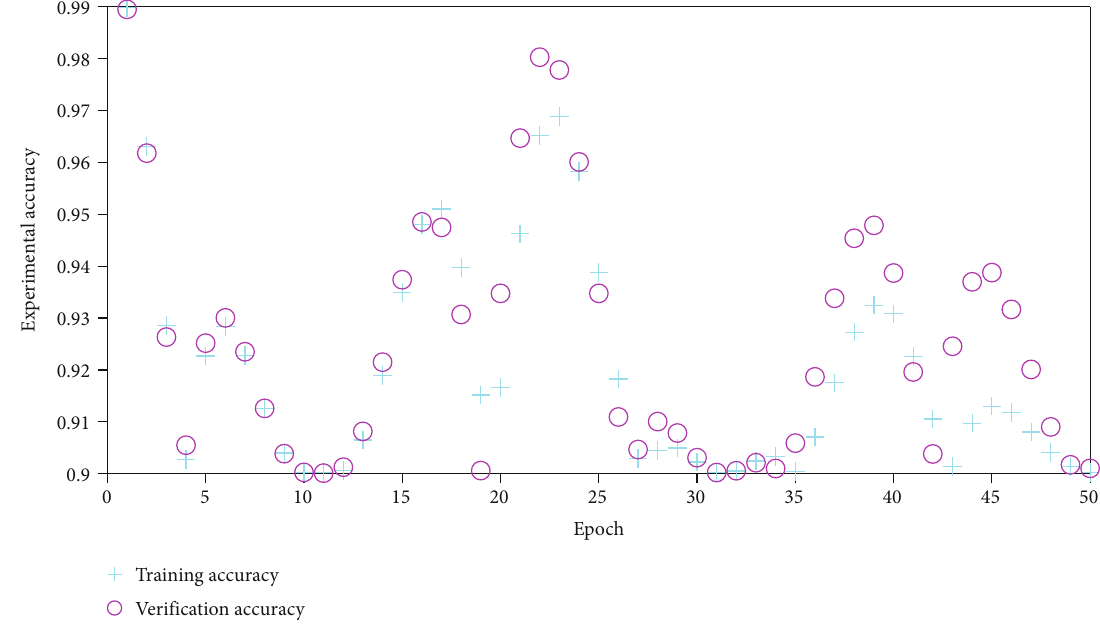
Figure 7: Accuracy map of automatic recognition of lowercase letter images based on partial di ff erential equation convolutional neural network based on mean curvature motion.